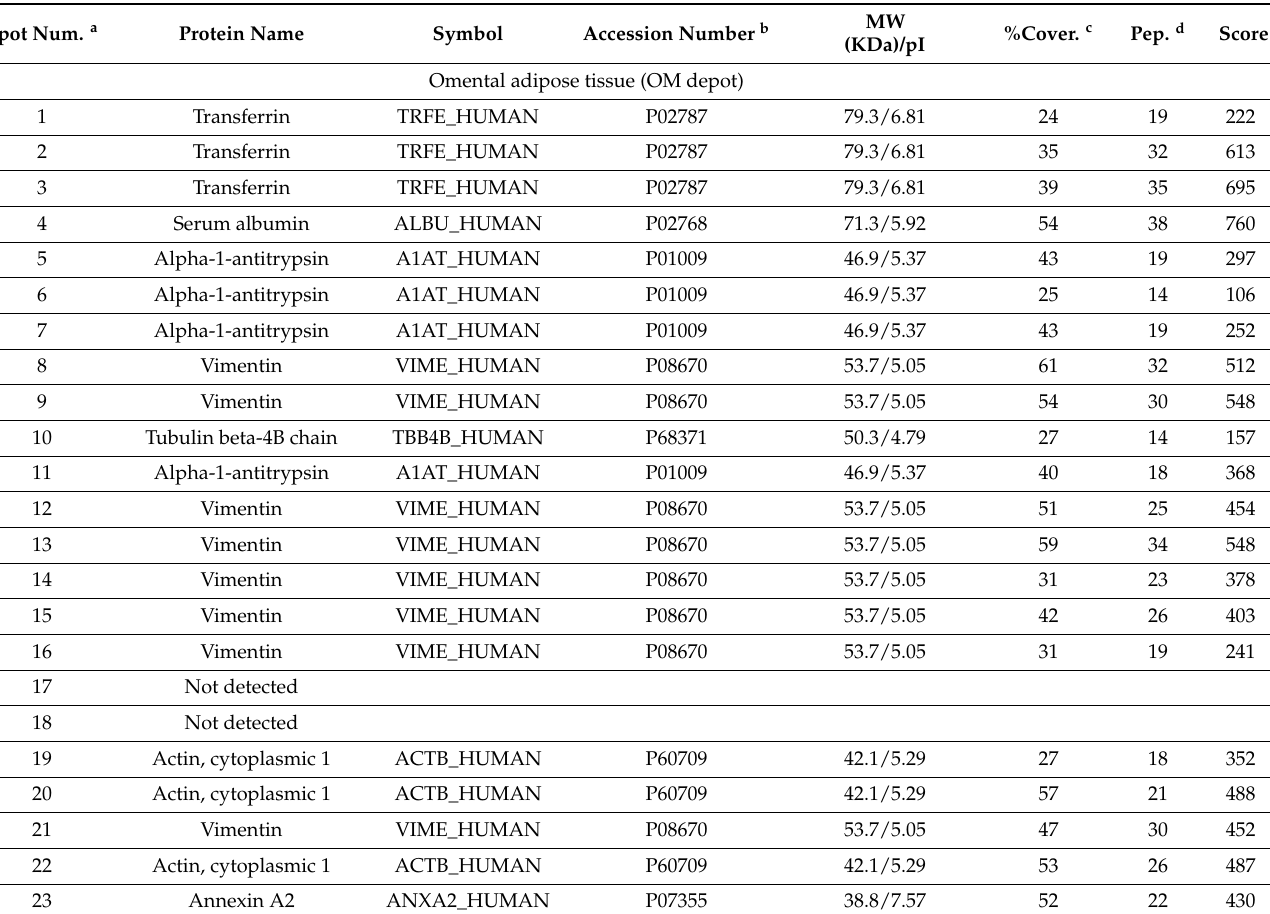
Table 2. Carbonylated proteins identified by MALDI-TOF/TOF in human adipose